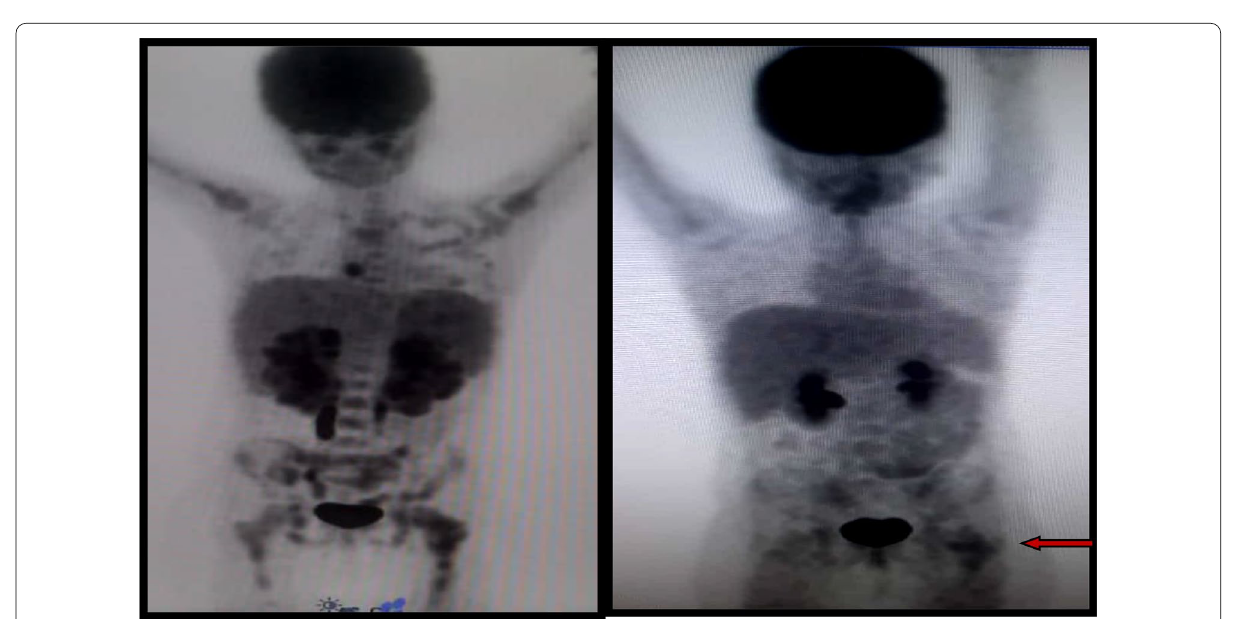
Fig. 6 PET‑CT study for an 8‑year‑old female child presented with fever and abdominal pain. Abdominal US revealed bilateral kidney masses that were pathologically proved to be non‑Hodgkin’s lymphoblastic lymphoma. To the left: Initial study shows metabolically active FDG‑avid infiltrates involving both kidneys, bone marrow, and bone. To the right: Interim PET‑CT study shows complete disappearance of all lesions except a residual bone marrow lesion at left femur with SUVmax ~ 2.63. The visual interpretation of this study using 5P‑DS was positive (score 4) as left femoral activity was higher than that of liver, while it was negative using rDS (rDS 1.05) which is less than the cutoff point (liver max ~ 2.5). The follow‑up showed = complete cure of the patient (35